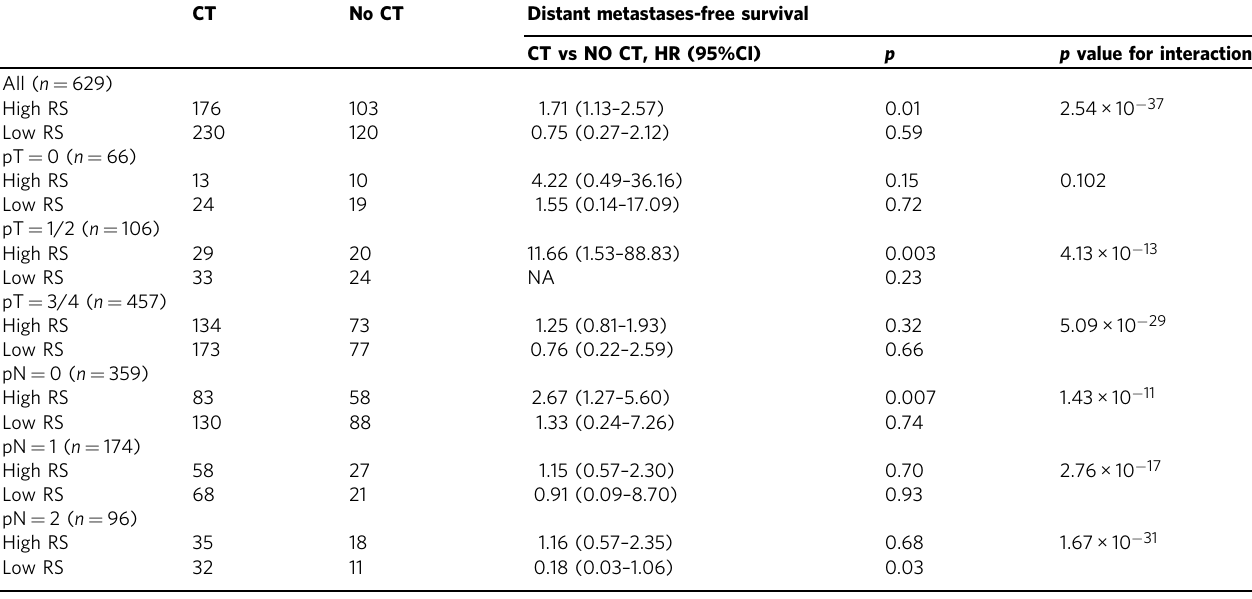
Table 3 Treatment interaction with radiomic signature and pathological stage for DMFS in patients with LARC. CT No CT Distant metastases-free